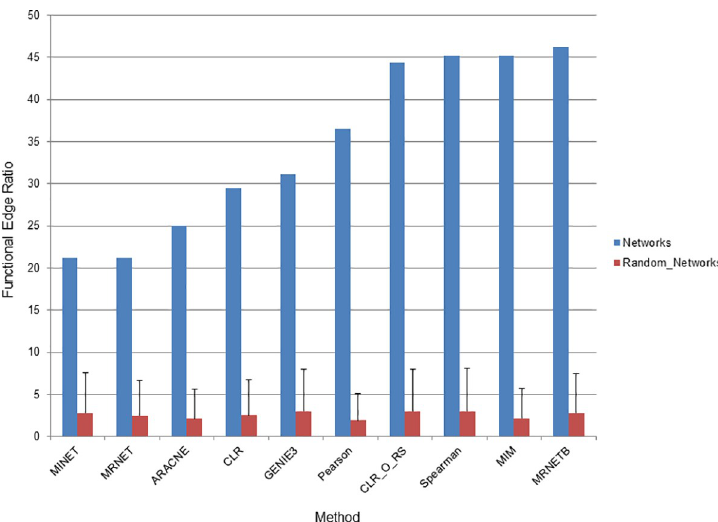
Fig 4. Quality of network inference methods. The ability of networks to connect features in the same functional category was interrogated. The ratio of edges (as a percentage) connecting annotated features in the same functional category to all edges connecting annotated features is displayed on the y-axis. The network inference method is displayed on the x-axis. A network of 5000 edges was examined for each network inference method. Blue bars represent ratios of edges in the networks described here and red bars represent ratios of edges when all nodes in the network have been randomized. Error bars indicate standard deviation of ratios from three randomized networks. CLR_O_RS indicates the original CLR algorithm with resampling to distinguish it from the version of CLR used in the MINET package.